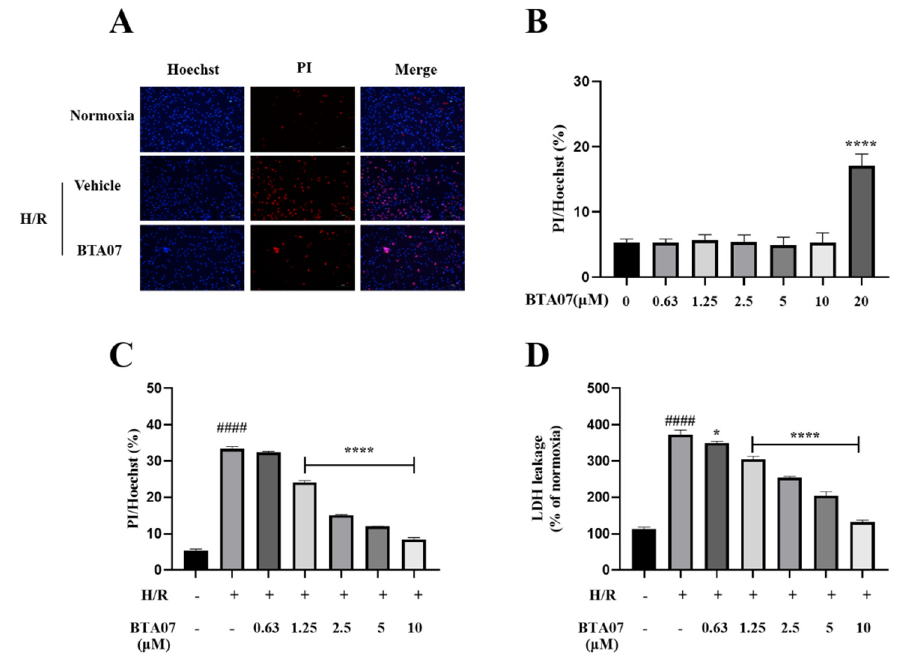
Figure 5. BTA07 decreased cell death rate and LDH release in ARCMs exposed to H/R. ( A ) Representative confocal microscopic images. ( B ) Cytotoxicity of BTA07 on ARCMs. The cells were incubated with different concentrations of BTA07 (0, 0.63, 1.25, 2.5, 5, 10 and 20 µ M). ( C ) Effect of BTA07 on cell death rate induced by H/Rin ARCMs. PI/Hoechst staining was used to calculate cell death rate. ( D ) Effect of BTA07 on LDH release in H/R-induced ARCMs. Data are presented as means ± S.E.M for three independent experiments. #### p < 0.0001 vs. normoxia group; **** p < 0.0001 vs. vehicle group; * p < 0.05 vs. vehicle group; one–way ANOVA test, followed by a Student–Newman–Keuls test.